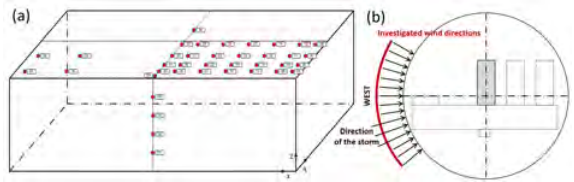
Figure 7. (a) Positions of the pressure measurement points and (b) the principal set-up of the model.